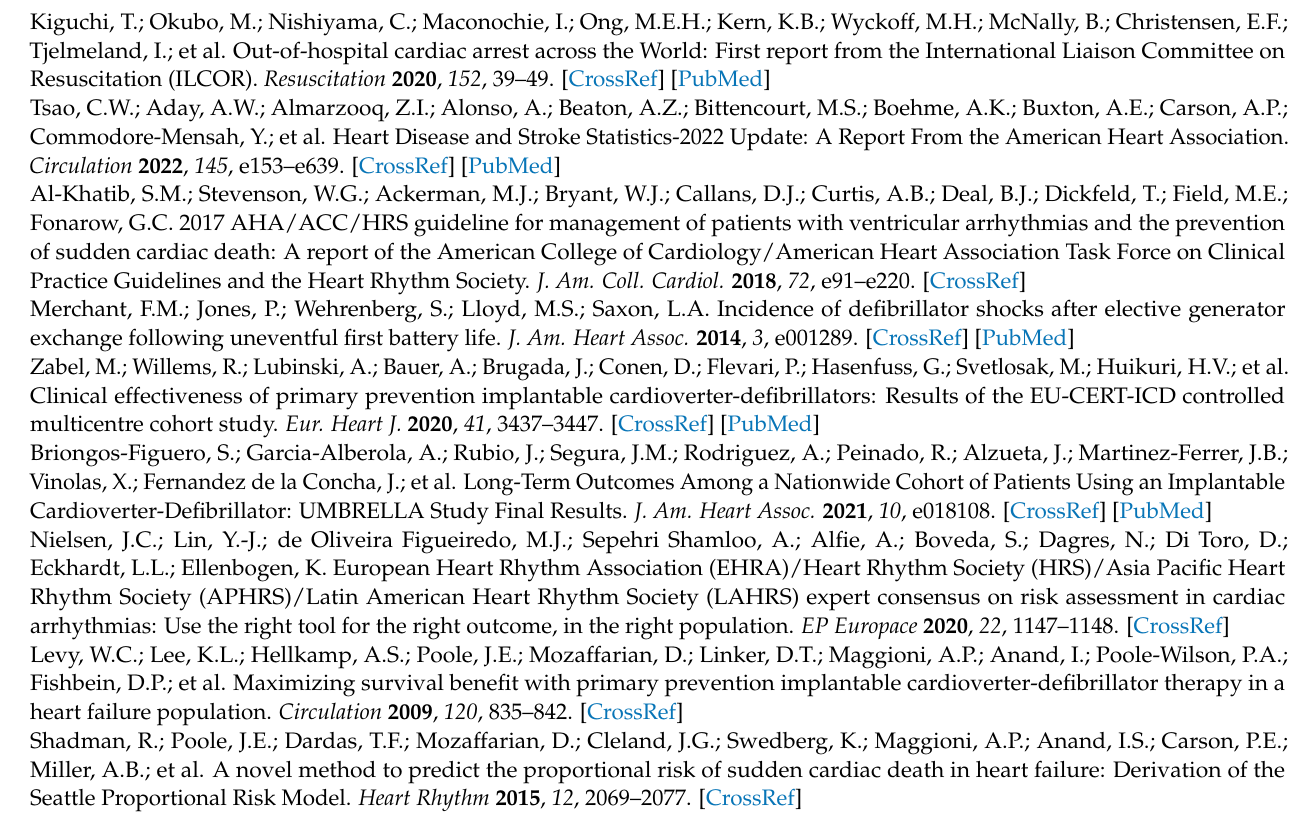
variables. Table S2: Data before and after Box-Cox transformation and standardization. Table S3: Model performance in the training test. Table S4: Univariable and multivariable Cox regression of all-cause death and first appropriate shock. Table S5: Parameter search space for each model in sensitivity analysis. Figure S1: Continuous variables’ contribution to the outcome in the XGBoost model predicting all-cause death. Figure S2: Continuous variables’ contribution to the outcome in the SSVM model predicting the first appropriate shock. Figure S3: Model interpretability using SHAP values. Figure S4: Comparison of C-index between CPH and ML algorithms in sensitivity analysis. Figure S5: Model interpretability using SHAP values in sensitivity